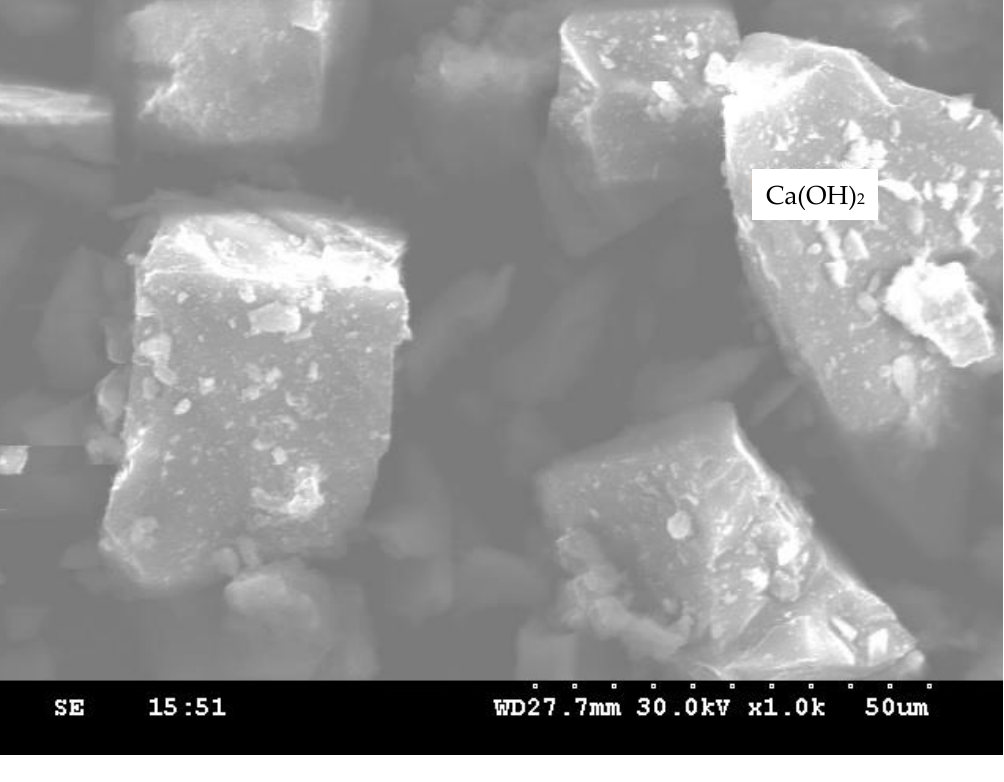
Figure 10. SEM image of control concrete.